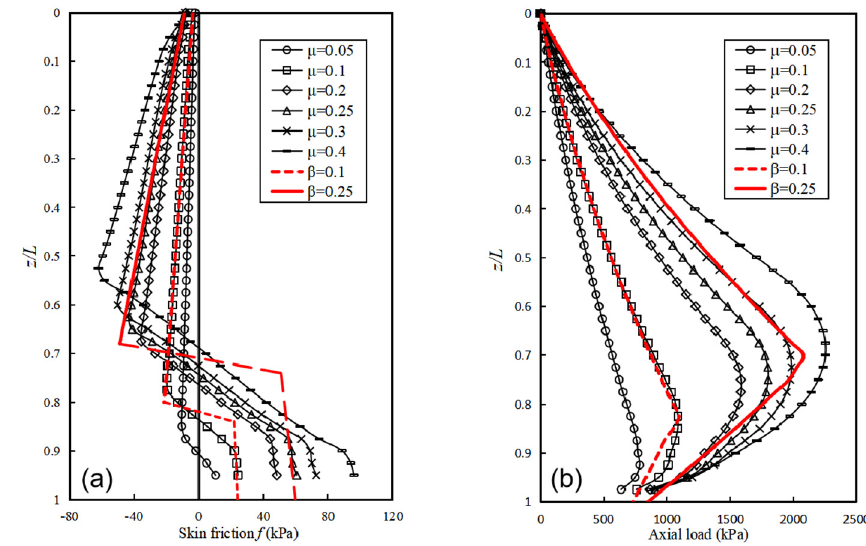
Figure 7. Effect of friction coefficient on ( a ) skin friction ( b ) and axial load.